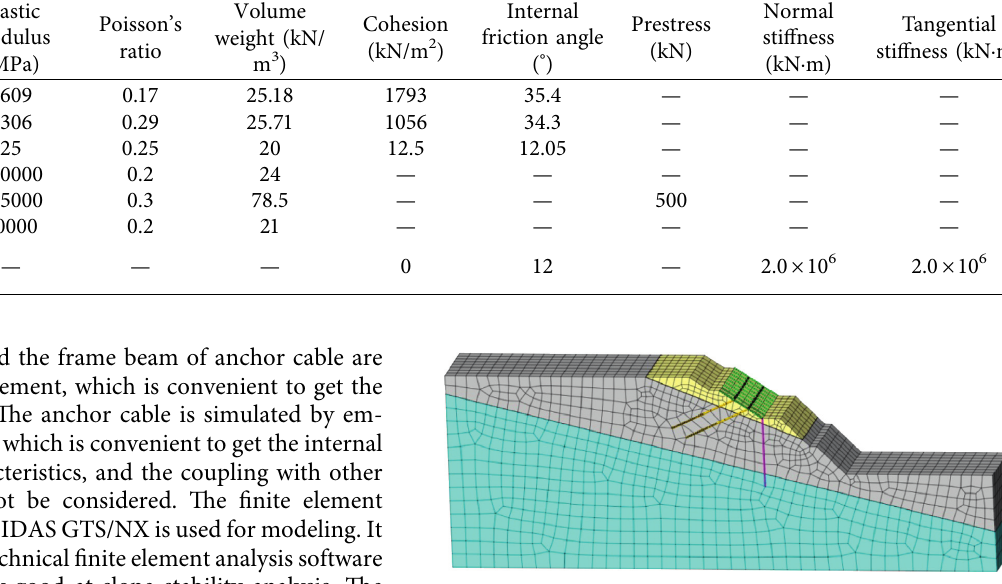
Figure 4: 3D finite element